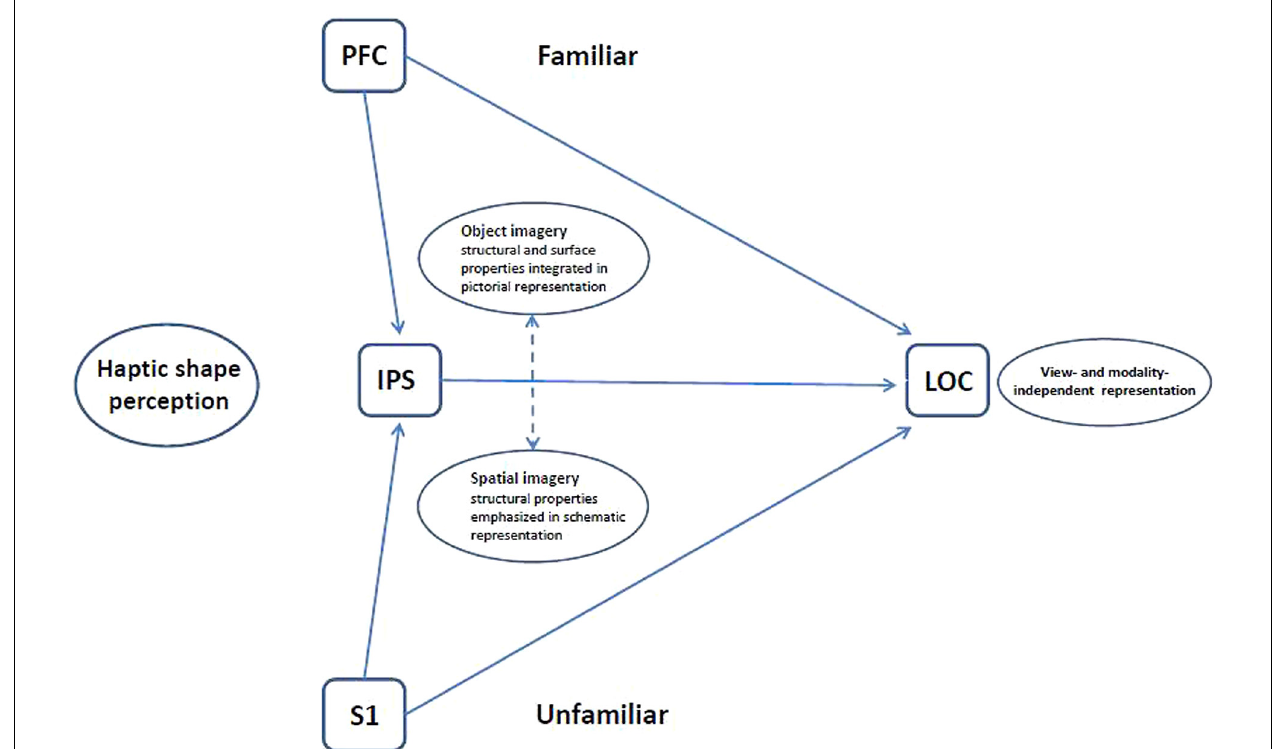
FIGURE 4 | Schematic model of haptic object representation in LOC modulated by object familiarity and imagery type. For unfamiliar more than familiar objects, the LOC is driven bottom-up from somatosensory cortex (S1) with support from spatial imagery processes in the IPS. For familiar more